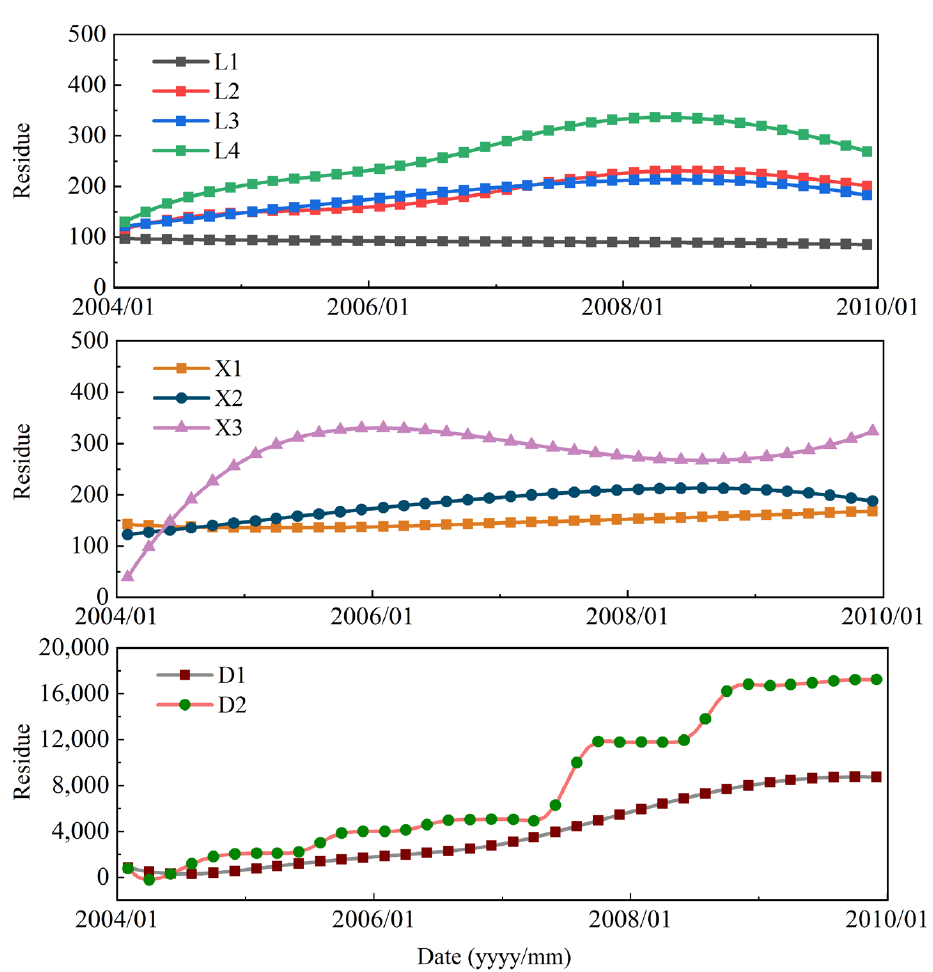
Figure 12. Residue term of restructured factors derived through CEEMD.